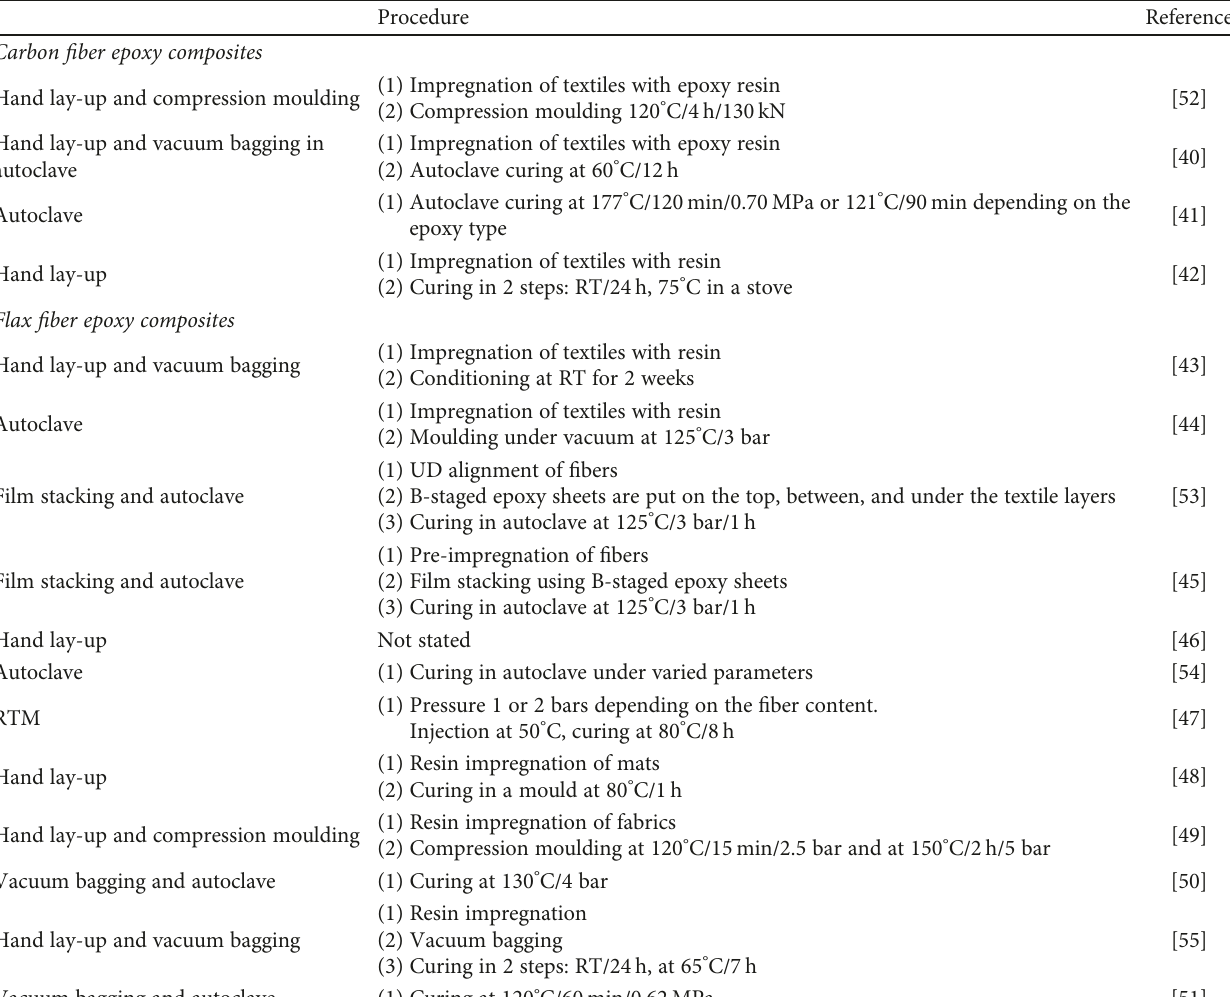
Table 6: Methods used for the manufacture of nonhybrid composites (Figures 2 –